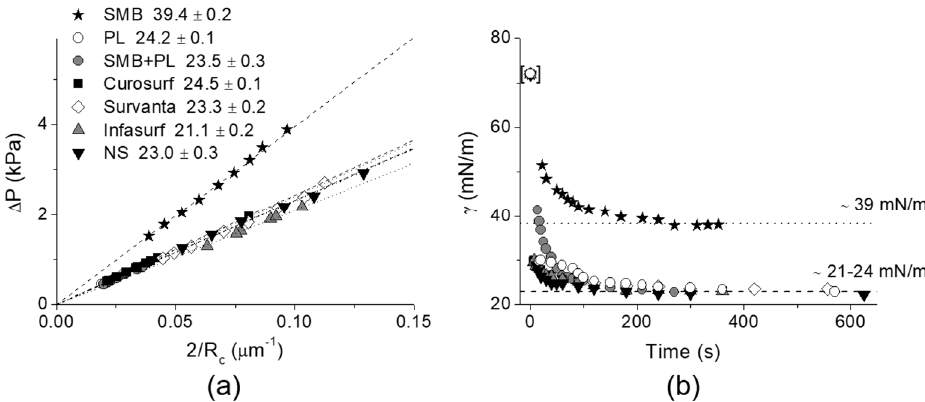
Figure 24. Equilibrium air-water surface tensions for lung surfactants in Tris buffer (pH 7) at 37 ◦ C. The data include 1 mg/mL suspensions of three different commercialised lung surfactants and extracted native surfactant (NS) from porcine lungs and the measurement of a synthetic lung surfactant formulation: 4% Super Mini-B (SMB) lung surfactant protein peptide in a phospholipid mixture (PL = DPPC:POPC:POPG 50:30:20 molar ratio), and the pure SMB peptide itself. ( a ) Equilibrium surface tension plot from the applied pressure vs. 2/ R c plot. The surface tension for each sample are shown in the legend derived as usual form linear fitting of the slopes. ( b ) Dynamic surface tension change of each sample by using the first-generation area expansion method developed by Lee et al. [9]. The symbols correspond between these two graphs. With permission from American Chemical Society [10].